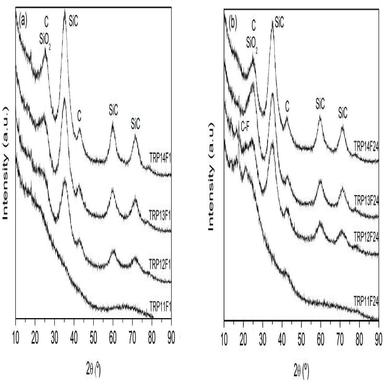
XRD patterns of SiOC-DC etched during (a) 1 or (b) 24 h at different pyrolysis temperatures.